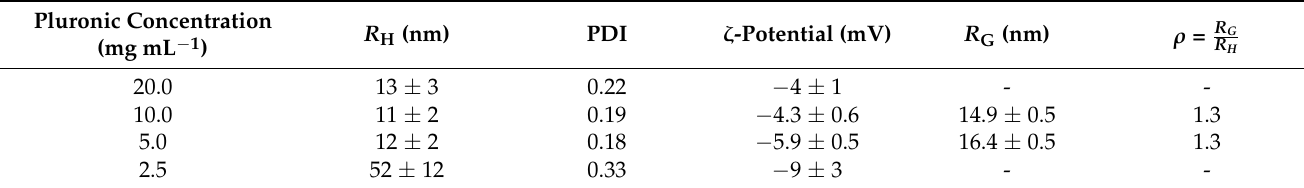
Table 1. Results for DLS and ELS evaluation for different CIP-loaded Pluronic micelle concentrations † in water. Pluronic Concentration